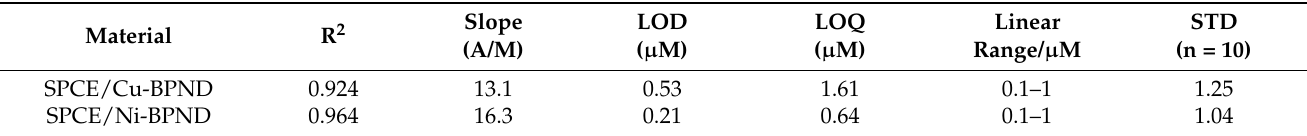
Table 3. Linear regression analysis of SPCE/Cu-BPND and SPCE/Ni-BPND sensors for DEA NONOate